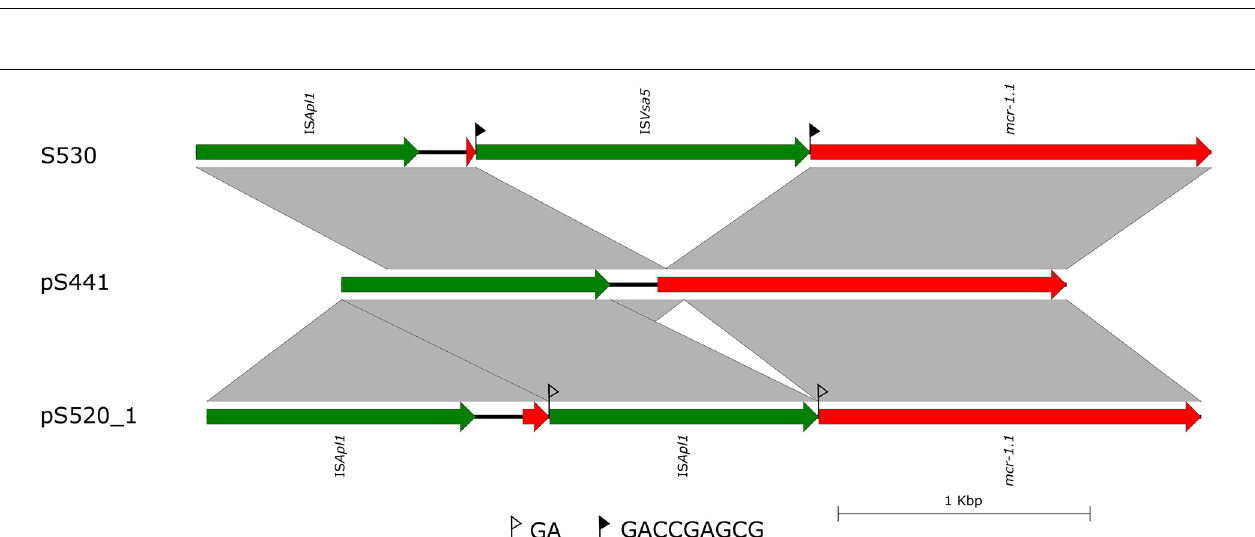
Frontiers in Microbiology |